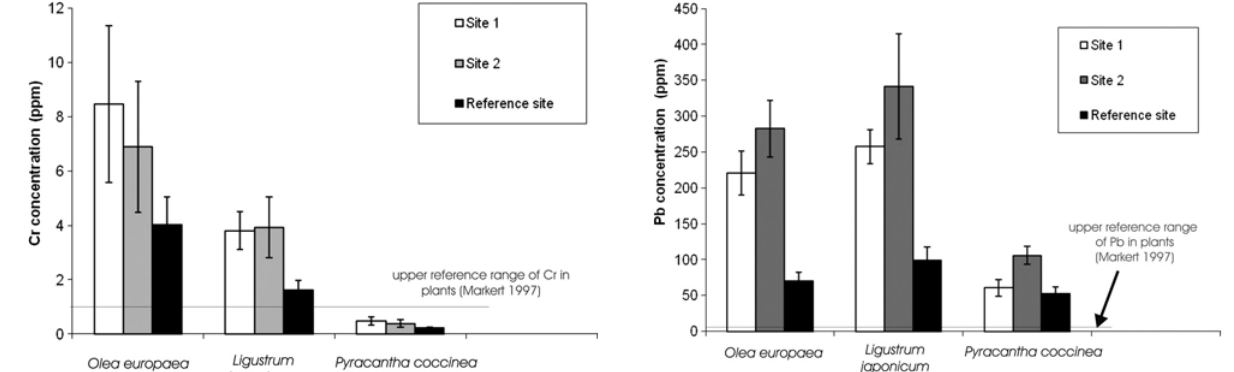
Fig. 3. Chromium concentrations (ppm dry wt) in the leaves of Olea europaea , Ligustrum japonicum, and Pyracantha coccinea from different studied sites (site 1: industry; site 2: traffic; reference site: botanical garden)